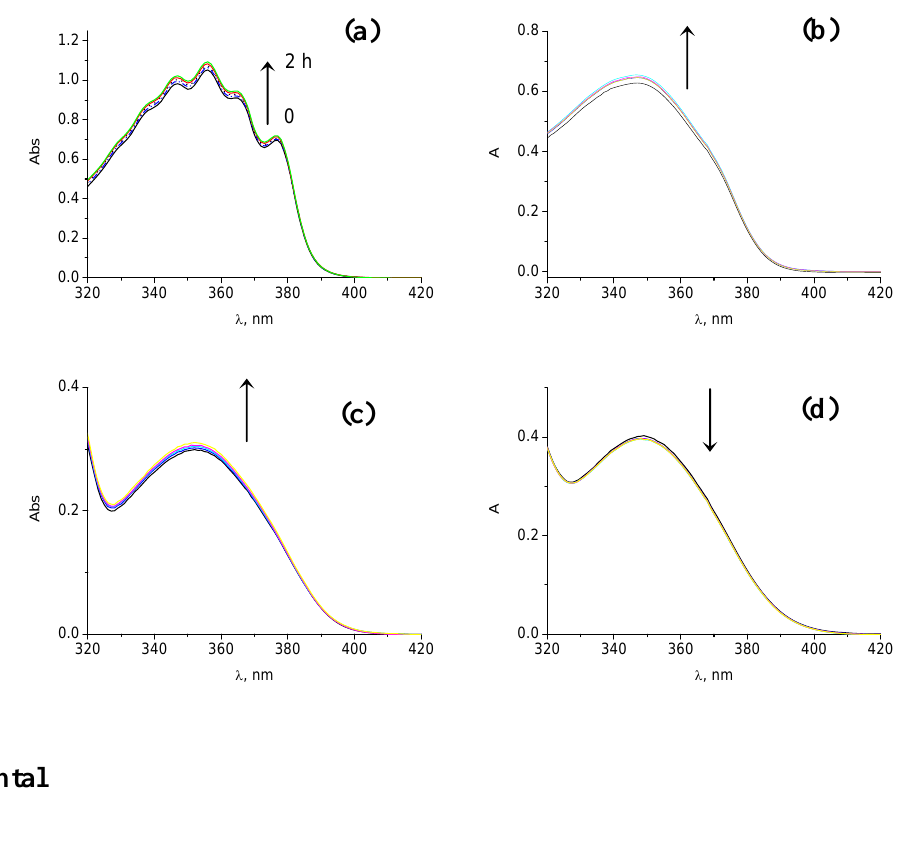
Figure 6. UVA-absorption changes after simulated solar irradiation (up to 2 h) of compound 2 in hexane (a) and ethanol (b). Same experiments with compound 1 in hexane (c) and ethanol (d)